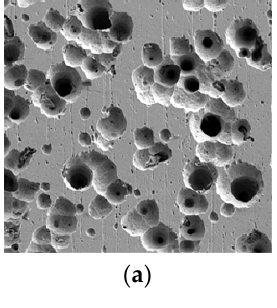
Figure 3. Corrosion morphology image after pretreatment at different Cl − concentrations : ( a ) 50% [Cl − ] Std ; ( b ) 100% [Cl − ] Std ; ( c ) 150% [Cl − ] Std ; ( d ) 200% [Cl − ] Std .